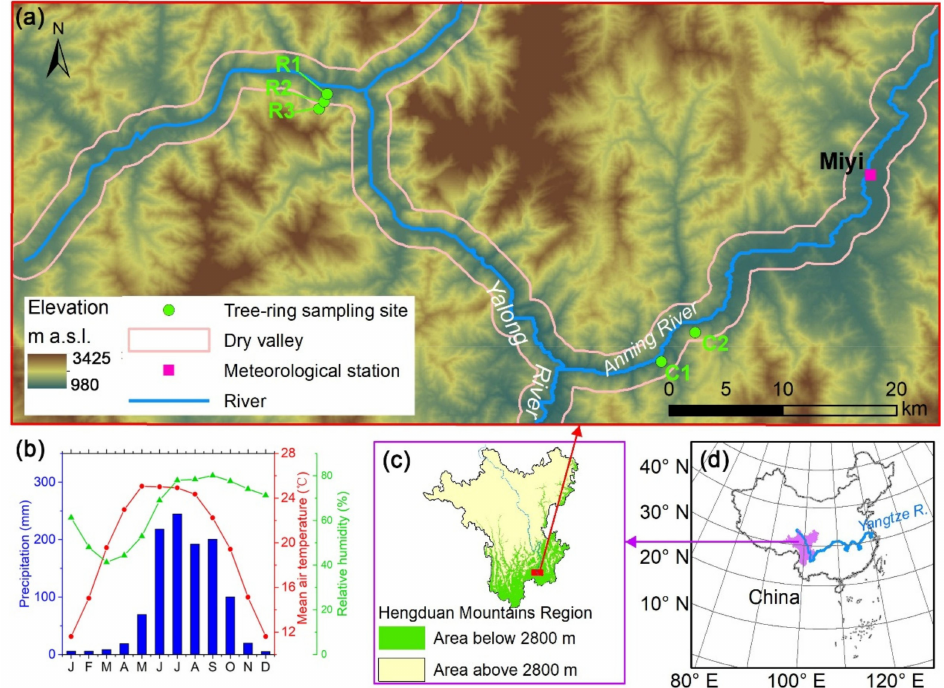
Figure 1. Location of the tree ring sampling sites and meteorological station Miyi. The pink lines in ( a ) are the borders of the dry valleys according to the definition of reference [37]; ( b ) shows the monthly climatic characteristics at station Miyi; and ( c , d ) indicate the locations of ( a ) in the Hengduan Mountains region and China,